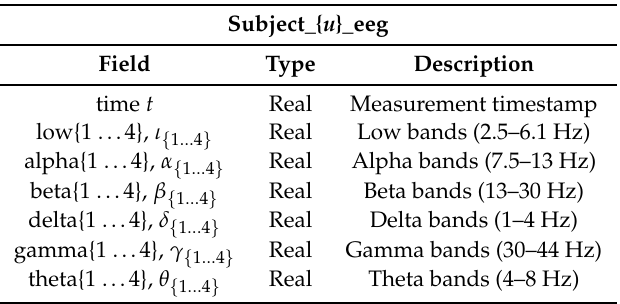
Table 2. Database table schema for subject u EEG (electroencephalography) values measured (in order TP9, Fp1, Fp2,